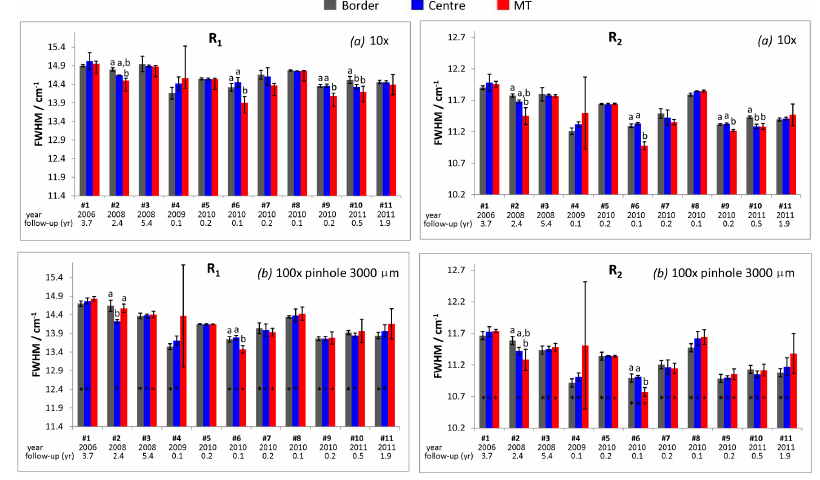
Figure 3. The average FWHM values (FWHM ± standard deviation) of the R 1 and R 2 bands as obtained from the fitting of the emission spectra recorded under optical conditions ( a ) and ( b ) in different areas of the explanted Biolox ® delta femoral heads. When present, different letters on the histogram bars indicate significant differences among the areas of each retrieval; asterisks indicate significant differences between the values measured under optical conditions ( a ) and ( b ) within the same area and in the same retrieval.